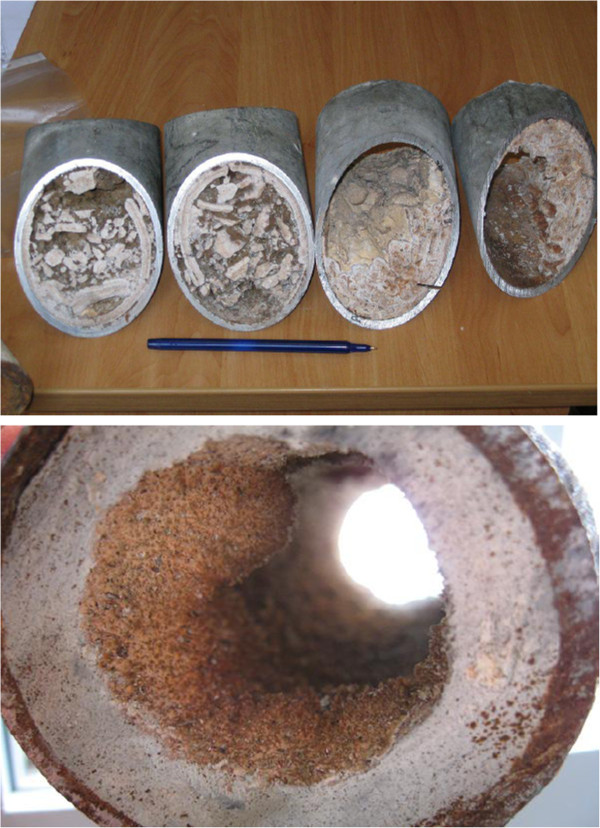
Inorganic deposits and biofilm in some of the water system tubes.